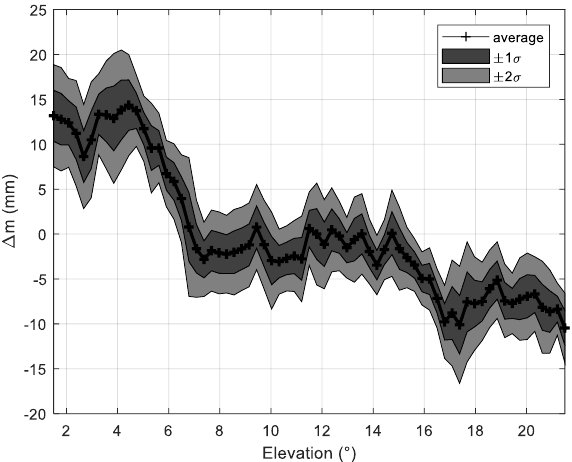
Figure 4. Statistical characteristics of G27 data in all no-rain days.